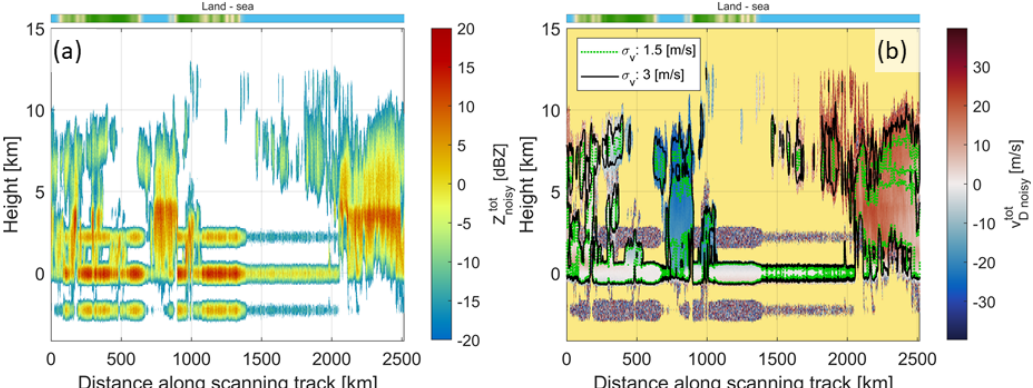
Figure 15. Reflectivity and Doppler velocity results corresponding to a full revolution of the WIVERN antenna, as shown in Fig. 13, for an integration length of 1.0km ( M =8). (a) Simulations of the WIVERN reflectivities (signal and noise) with ghost echoes at 2.3km above and below the ground due to the depolarization by the surface, leading to ghost echoes where there is no real cloud. (b) WIVERN retrieved line-of-sight Doppler velocities after performing the polarization diversity pulse pair processing. Black solid and green dashed contour lines correspond to Doppler velocity precision computed, according to Eq. (16), of 3 and 1.5ms − 1 , respectively. Note that the echoes contaminated by ghosts have lower precision.